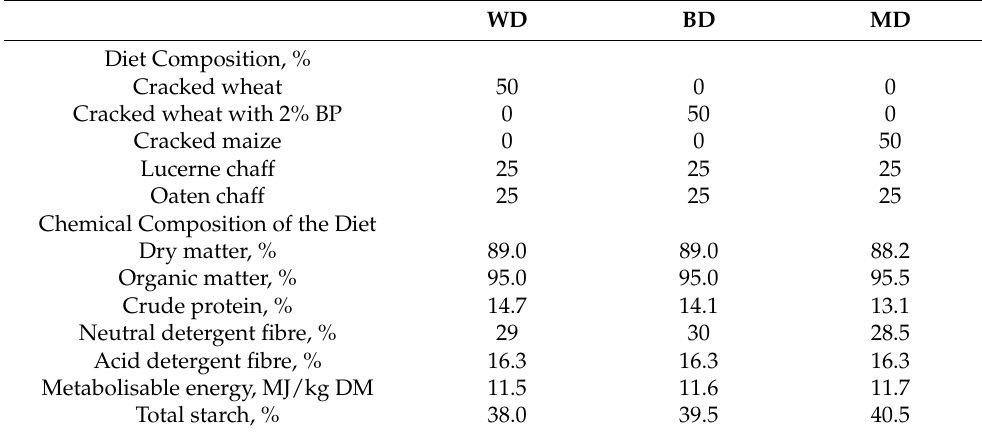
Table 1. Chemical composition of the experimental